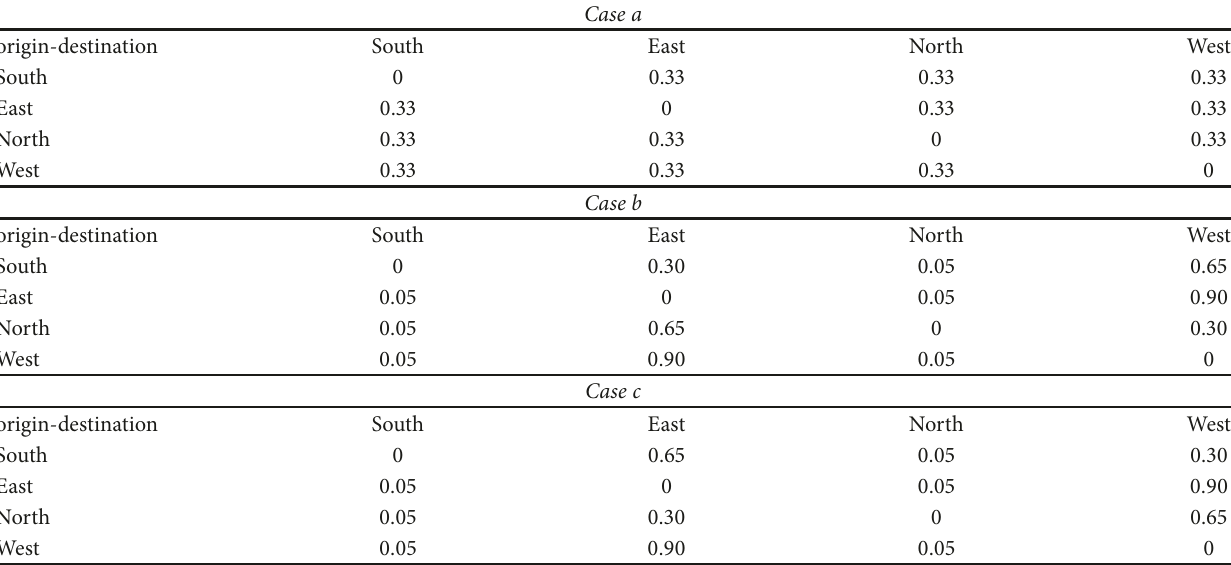
Table 5: Origin-destination matrix of traffic flow percentages